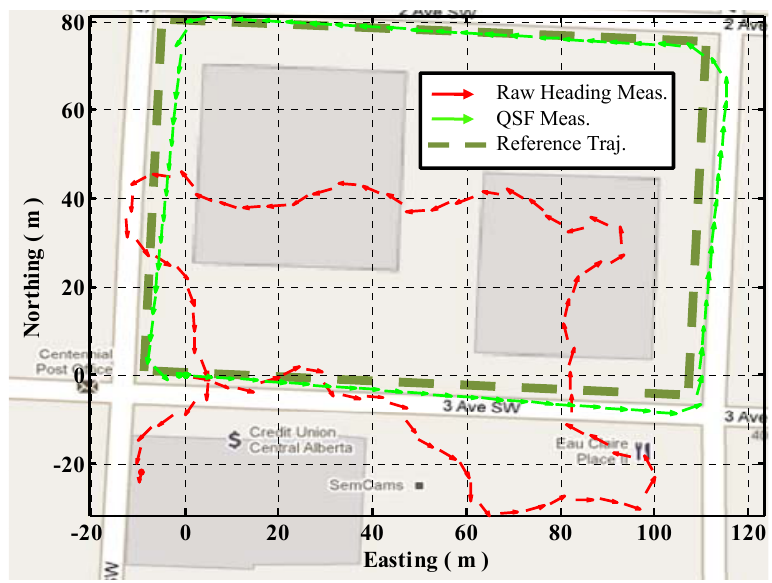
Figure 12. Raw heading measurements versus QSF measurements.